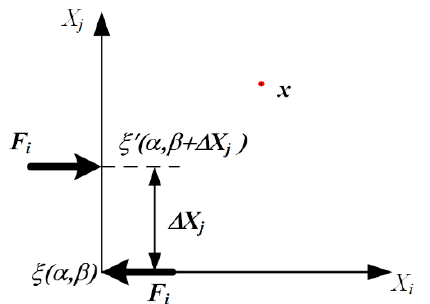
Figure 1. Schematic diagram of coupling force generating torque at small distances.